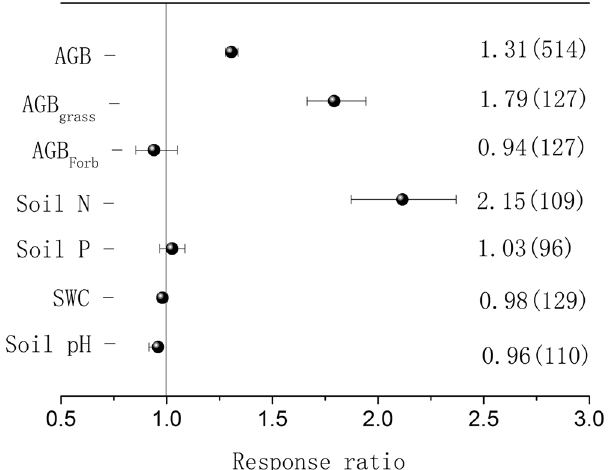
Figure 1. Effects of nitrogen (N) addition on aboveground biomass (AGB), the AGB of grasses (AGB grass ), the AGB of forbs (AGB forb ), soil available nitrogen (N) concentrations, soil available phosphorus (P) concentrations, soil water content, and soil pH. The numbers outside and inside the parentheses represent the response ratio (RR) and the number of observations, respectively. The dots with error bars are the means with 95% confidence